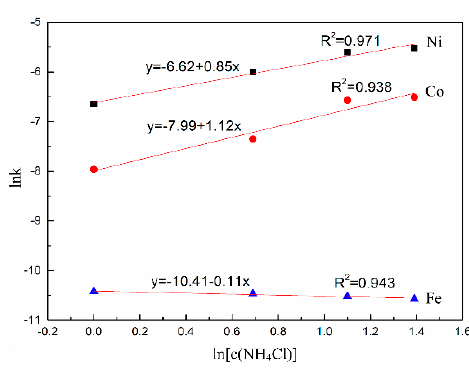
Figure 11. The ln k − ln c(HCl) of Ni, Co, and Fe.